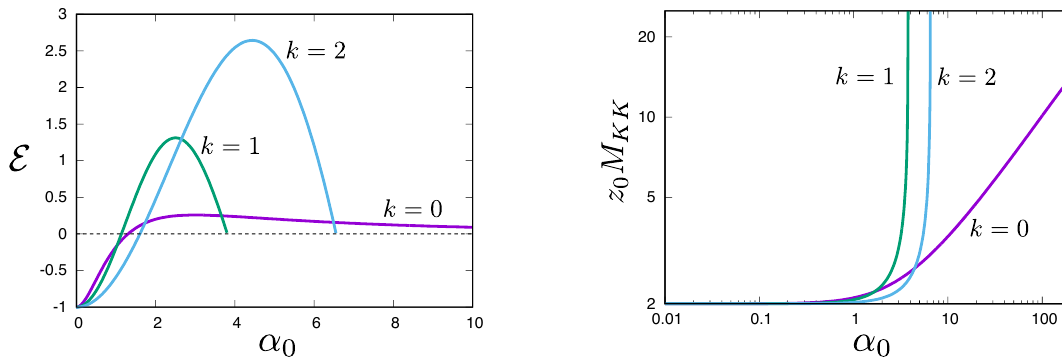
Figure 1. (Left) Energy density as a function of (cid:11) 0 . (Right) Location of the tip of the AdS soliton z 0 as a function of (cid:11) 0